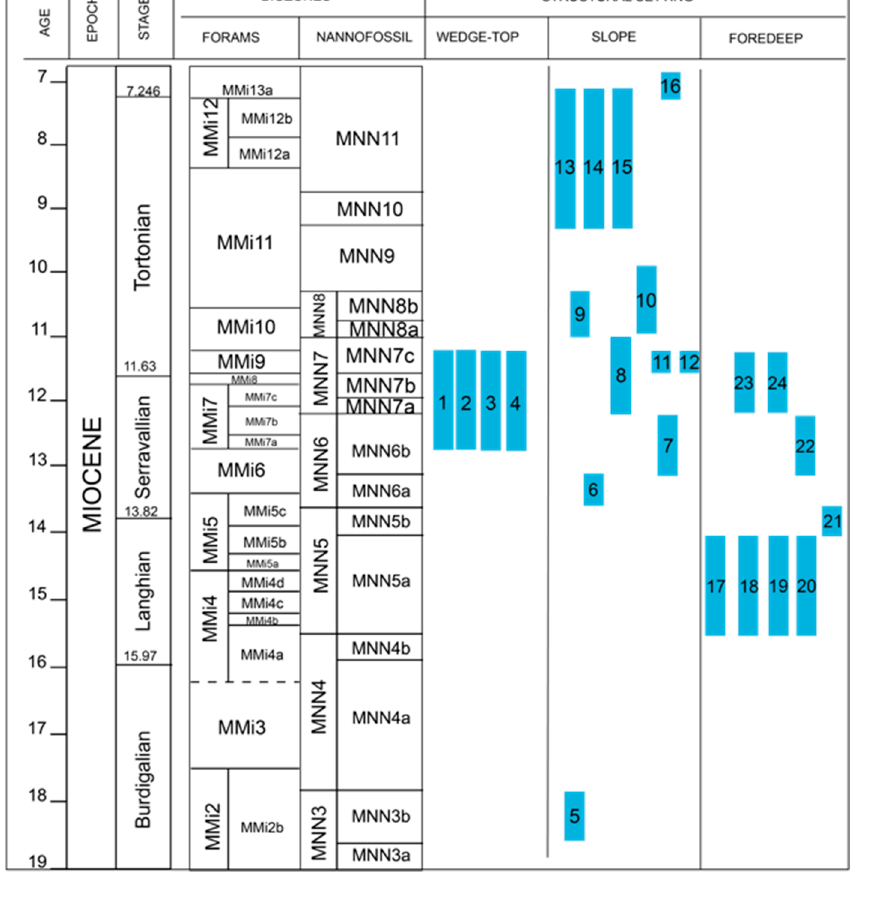
Figure 7. Nannofossil and foraminifera biostratigraphic framework indicating the distribution of the examined outcrops (numbers refer to Figure 1).